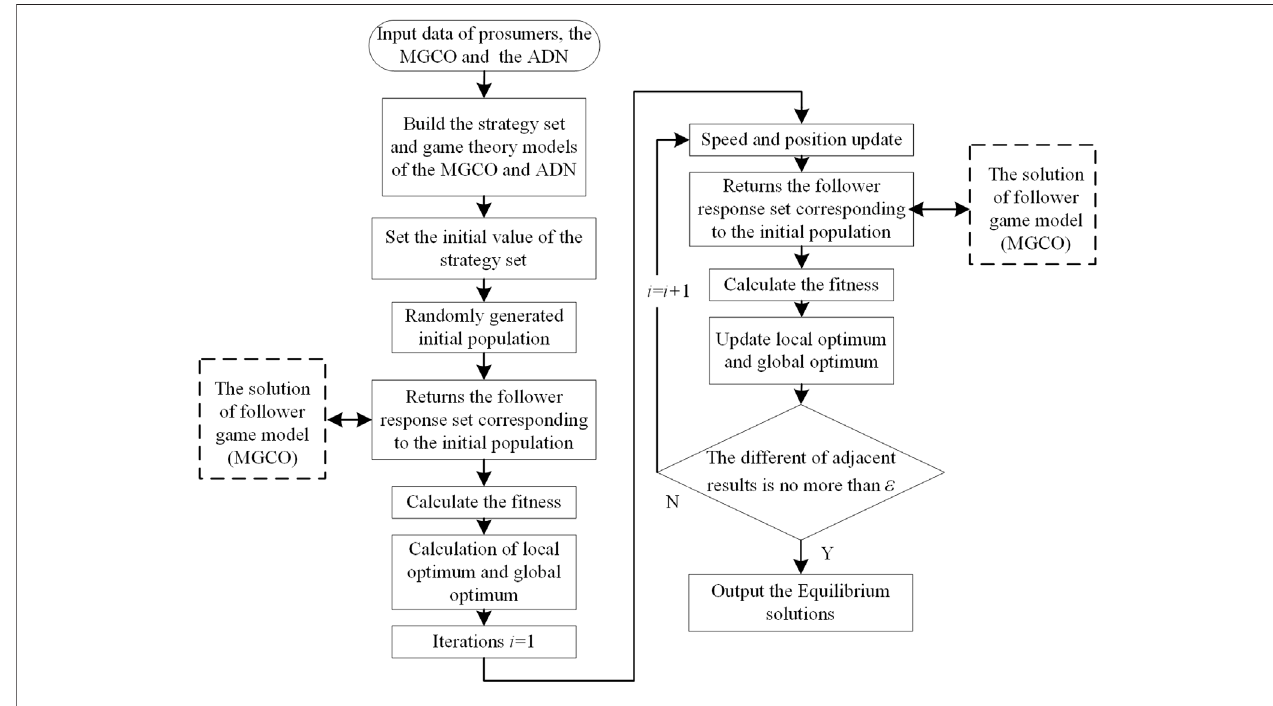
FIGURE 2 | Solving process of the proposed game model.